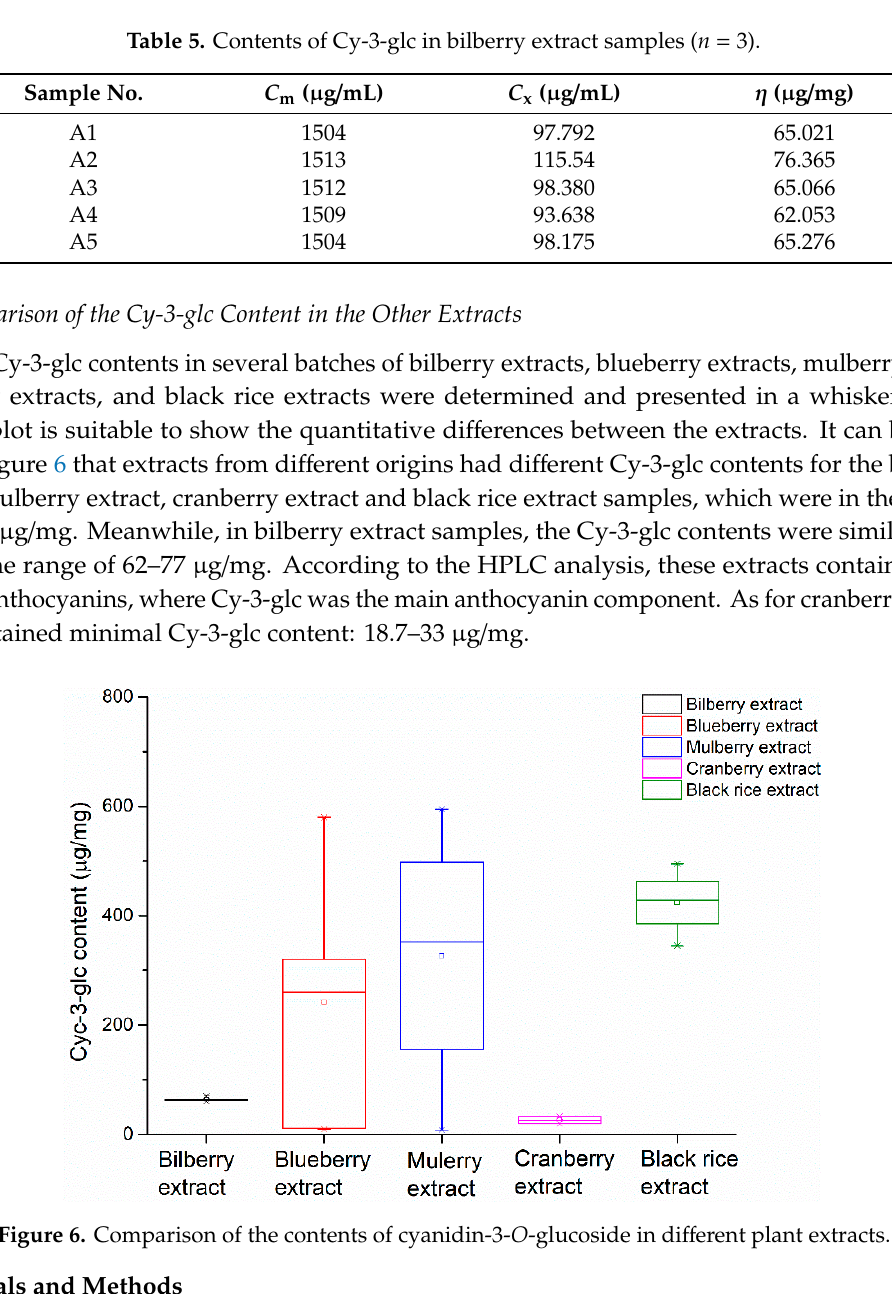
Table 6. Information about the extract samples.